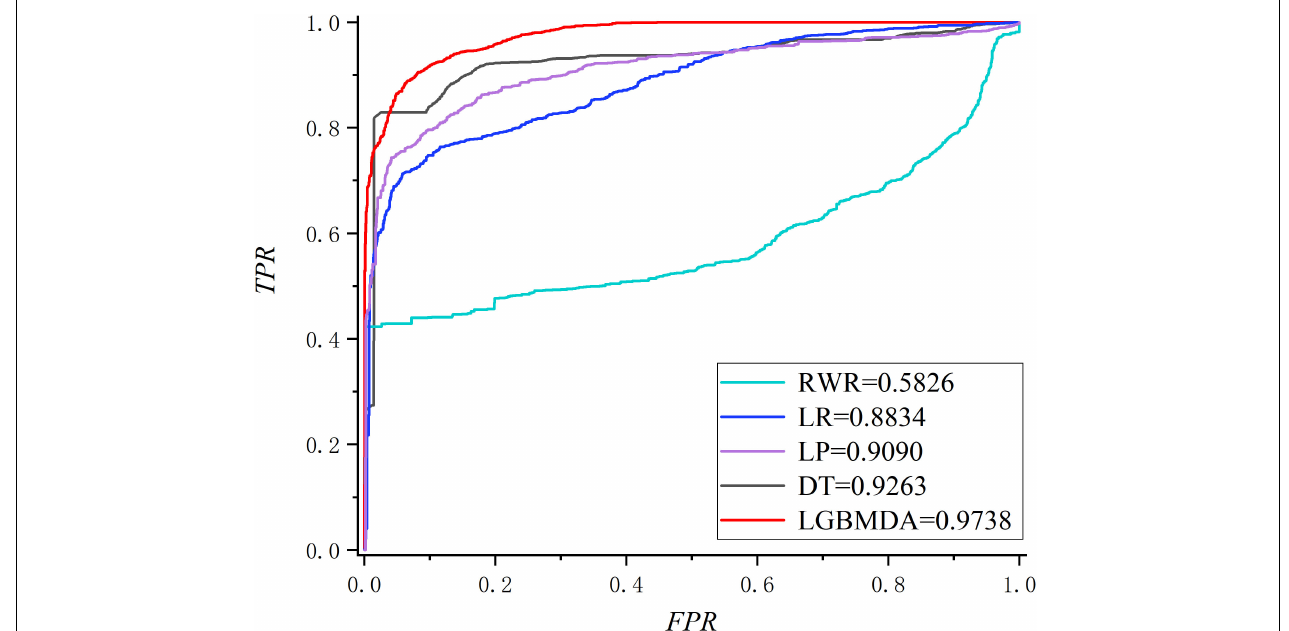
FIGURE 3 | The ROC about